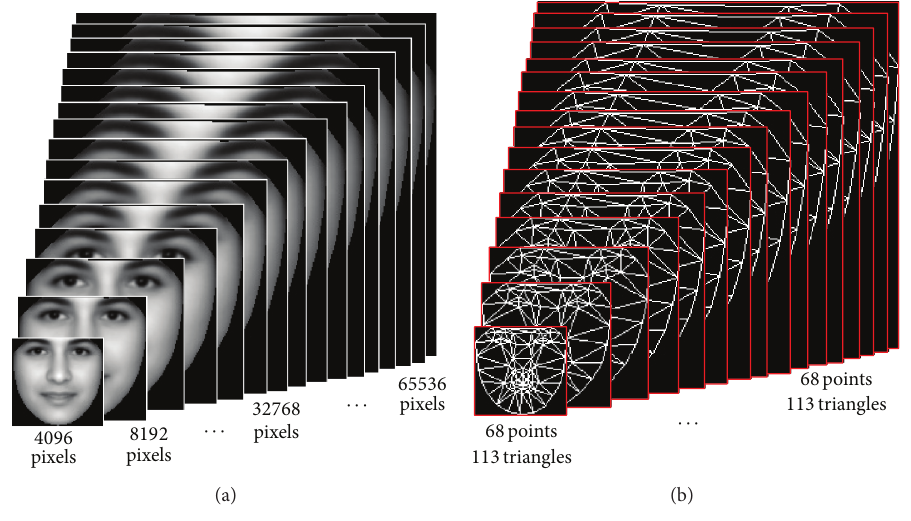
Figure 5: (a) Texture templates and (b) shape